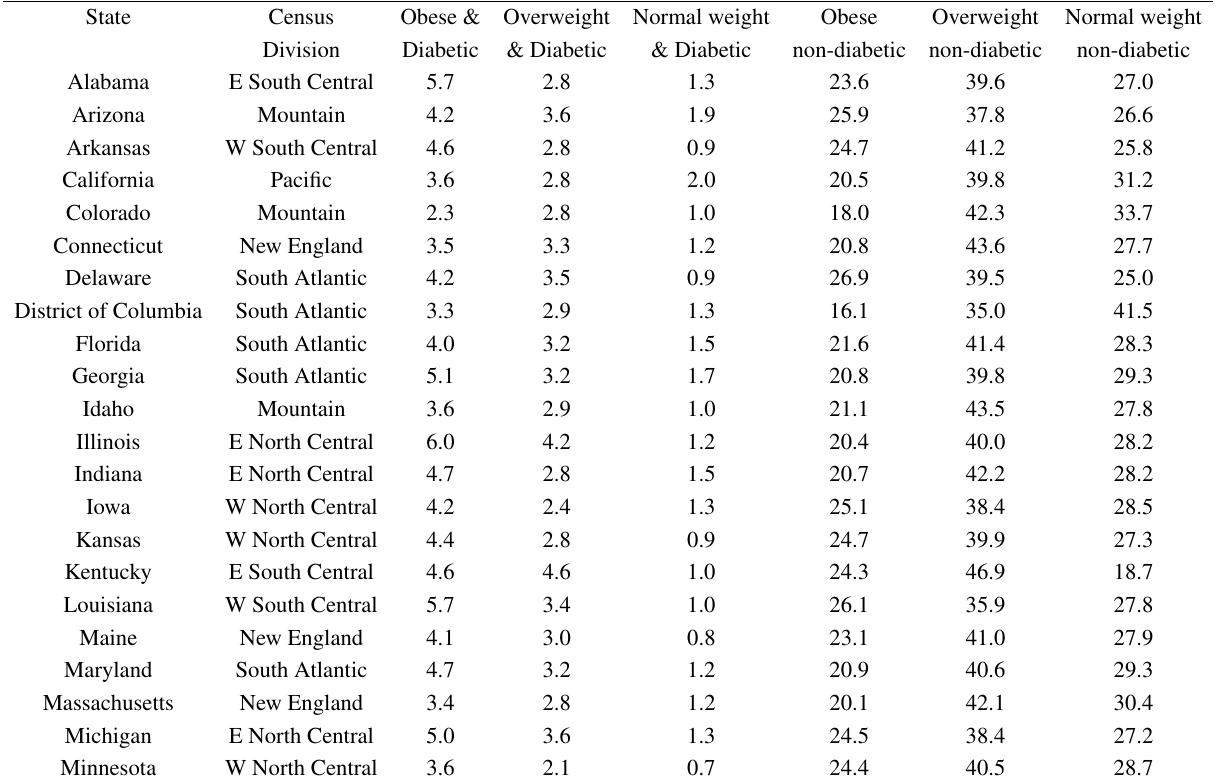
Table 3 . Percentage prevalence of obesity-diabetes status, by